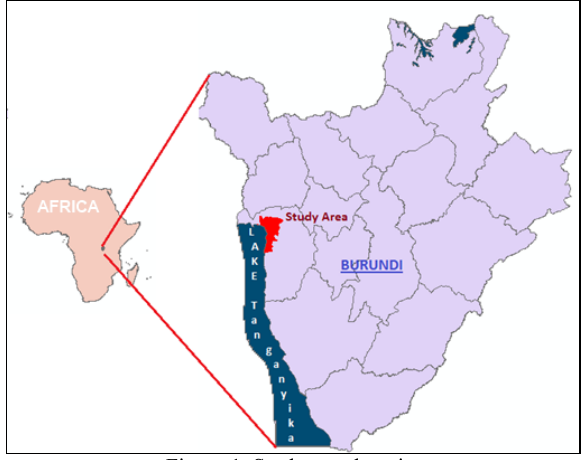
Figure 1. Study area location